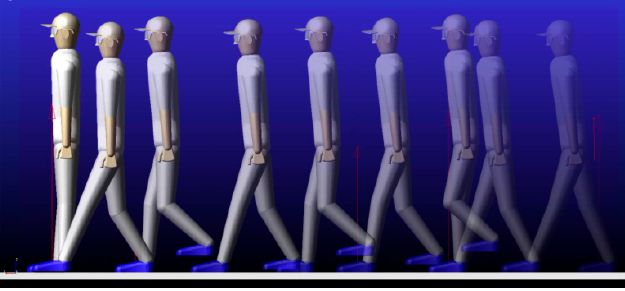
Figure 20. Dynamic simulation of human body.